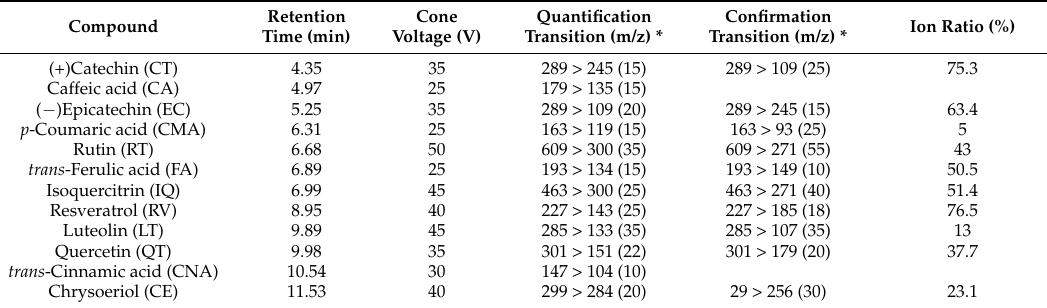
Table 1. ESI-MS analysis for the 12 standard phenolic